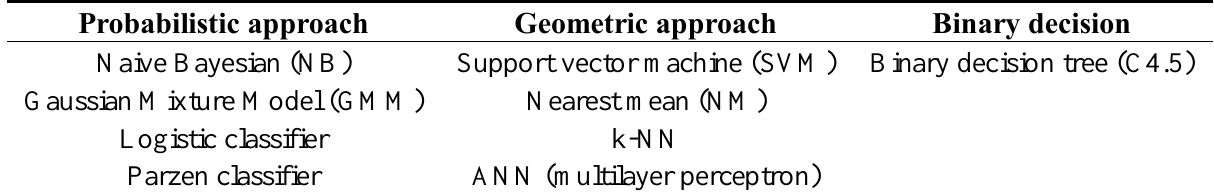
Table 3. Single-frame